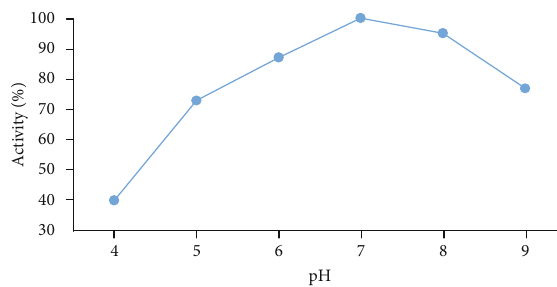
Figure 5: The e ff ect of pH on biosensor response.